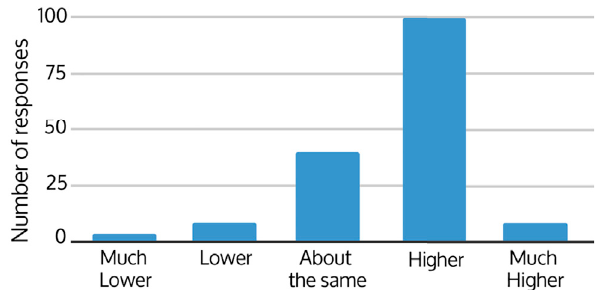
Figure 4B ; Wilcoxon test p (cid:1) 0.649). Overall, approximately 30% of